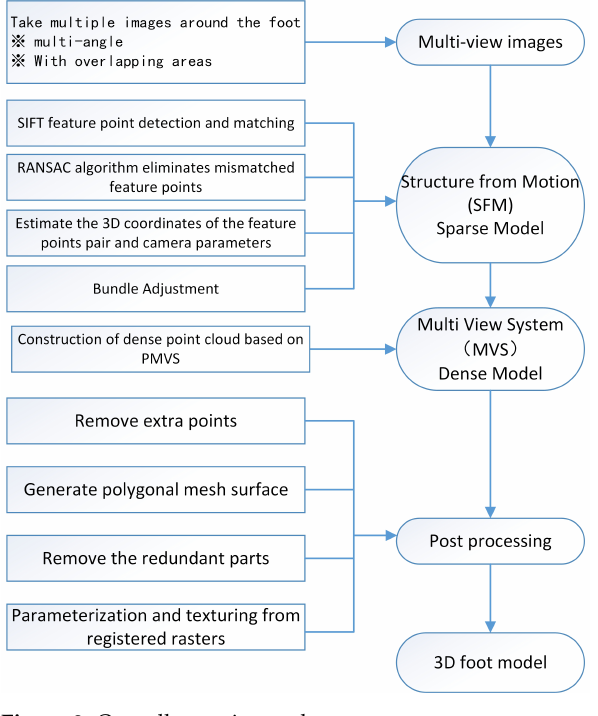
Figure 2. Overall experimental